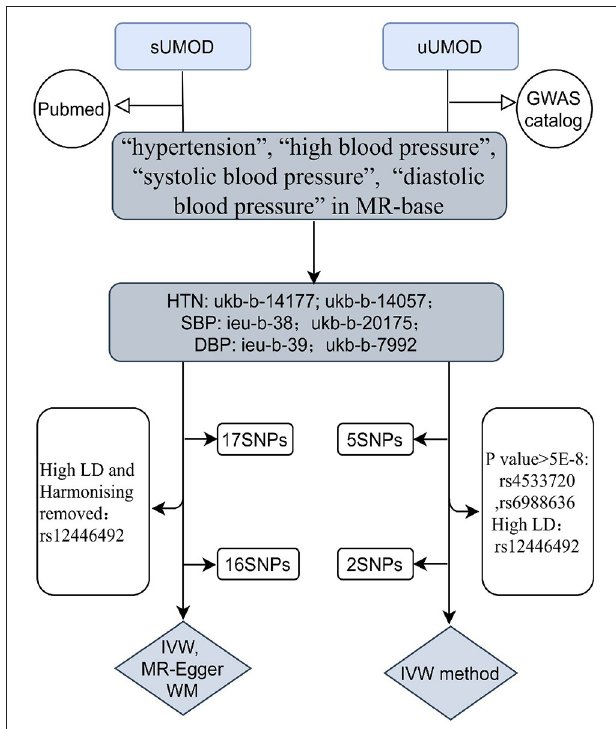
FIGURE 2 | The flow chart of the study design. For instrumental variants (IVs) of the uUMOD, we removed two SNPs (rs4533720 and rs6988636) because of their p -value ( > 5e-8), and one SNP (rs12446492) due to its high linkage disequilibrium (LD) to rs12917707 (r20 = 0.16). For IVs of the sUMOD, rs12446492 was excluded for the same reason as uUMOD being palindromic with intermediate allele frequencies. uUMOD, Urinary uromodulin; sUMOD, Serum uromodulin; SBP, Systolic blood pressure; DBP, Diastolic blood pressure; HTN, Hypertension; IVW, Inverse variance weighted; WM, Weighted median; MR-Egger, Mendelian randomization-Egger; SNPs, Single Nucleotide Polymorphisms.